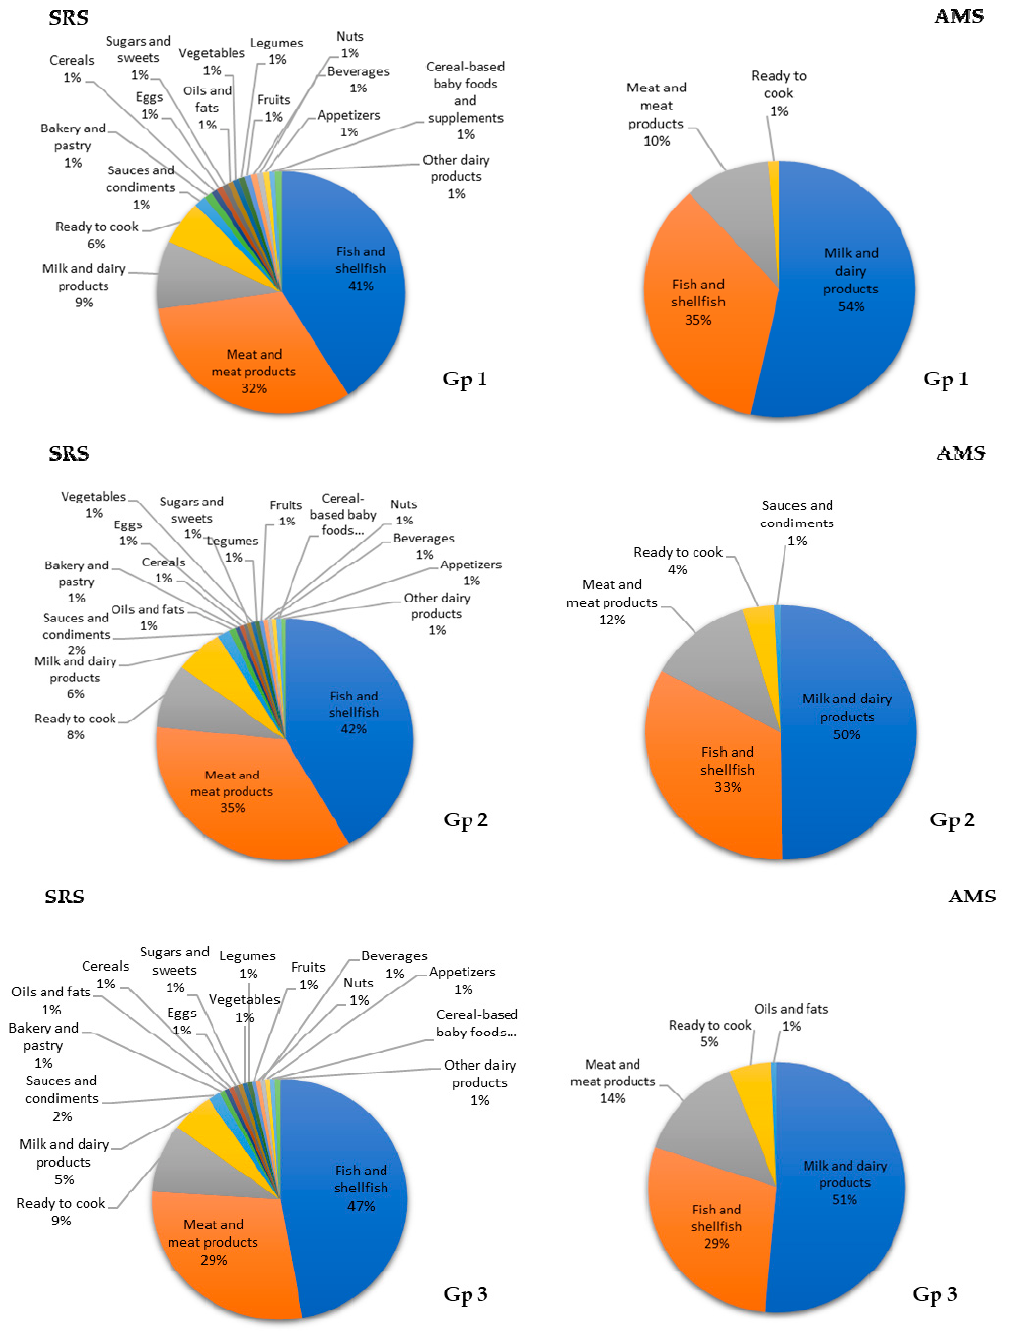
Figure 5. Contribution (%) of the 18 food group to docosahexaenoic acid (DHA) intake in the EsNuPI study population (Spanish Reference Cohort (SRS) and Adapted Milk Consumers Cohort (AMS)) according to age group (( Gp 1 ), 1 to < 3 years; ( Gp 2 ), 3 to < 6 years; ( Gp 3 ), 6 to < 10 years).